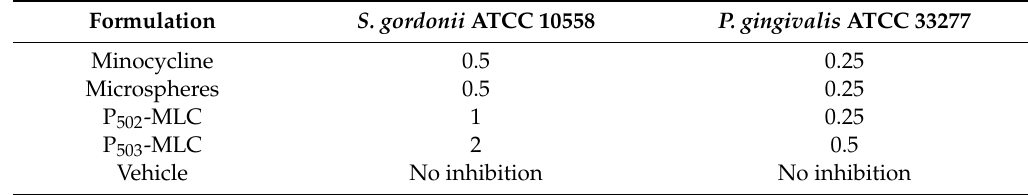
Table 2. Minimal inhibitory concentrations of the minocycline formulations (equivalent to µ g / mL minocycline).